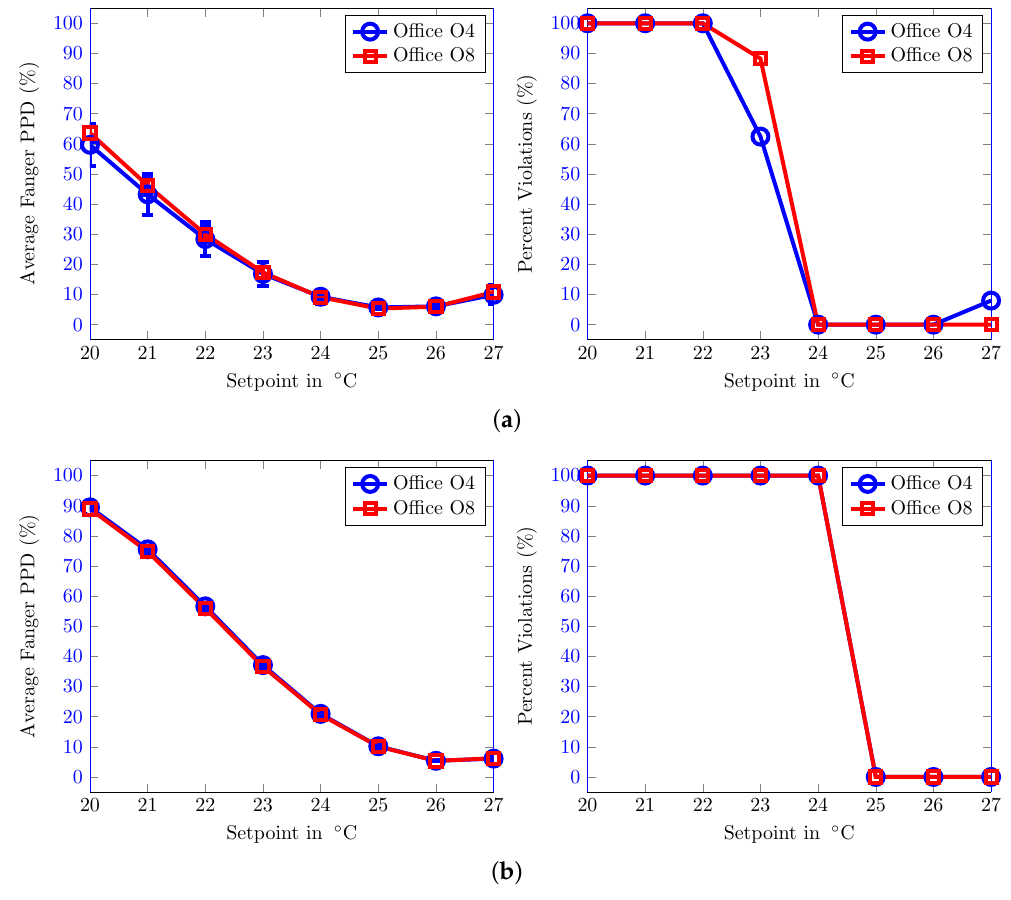
Figure 14. Summer experiments with different set-points. ( a ) User comfort evaluation for different air temperature set-points for the summer period; and ( b ) user comfort evaluation for different operative temperature set-points for the summer period.